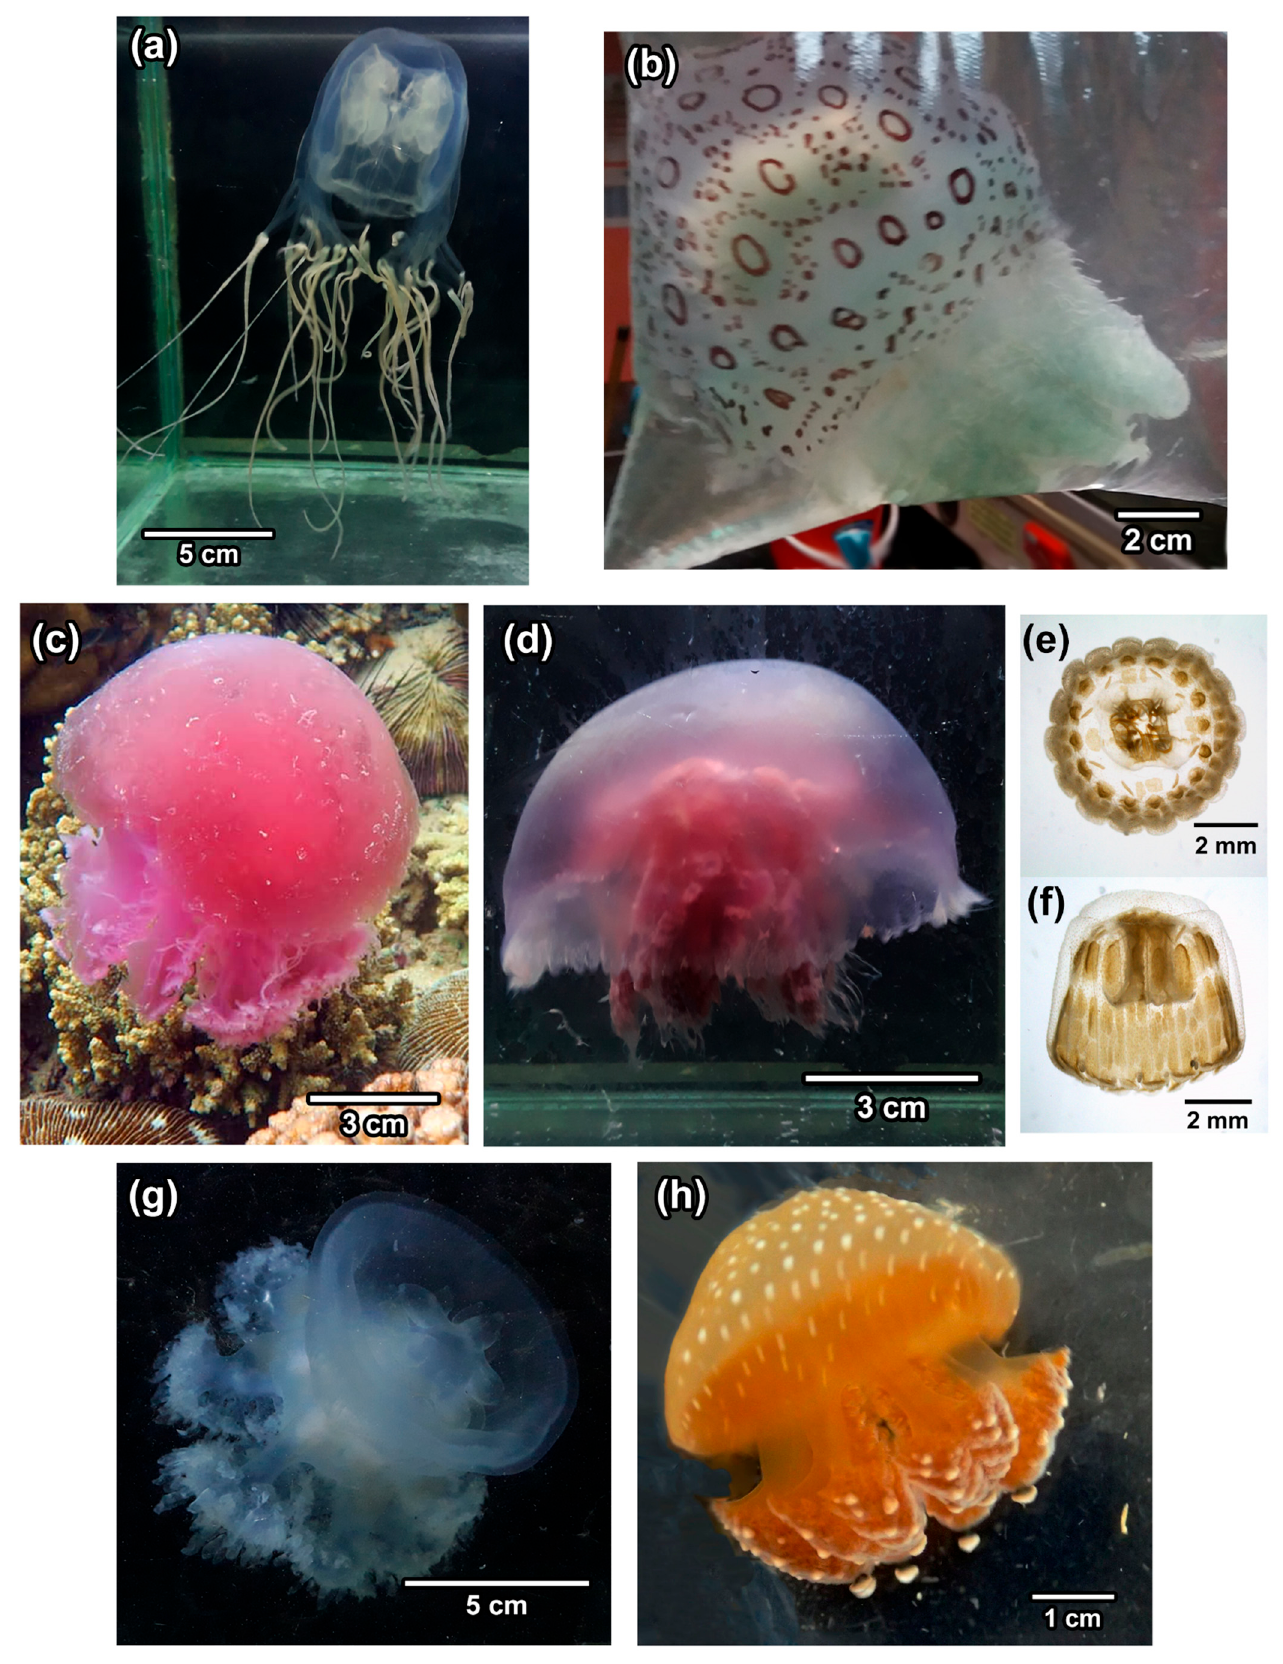
Figure 1. Jellyfish species identified in this study from Sabah. ( a ) Chironex yamaguchii , ( b ) Acromitus maculosus , ( c , d ) Crambione mastigophora , ( e , f ) Linuche aquila , ( g ) Netrostoma sp., and ( h ) Phyllorhiza punctata .